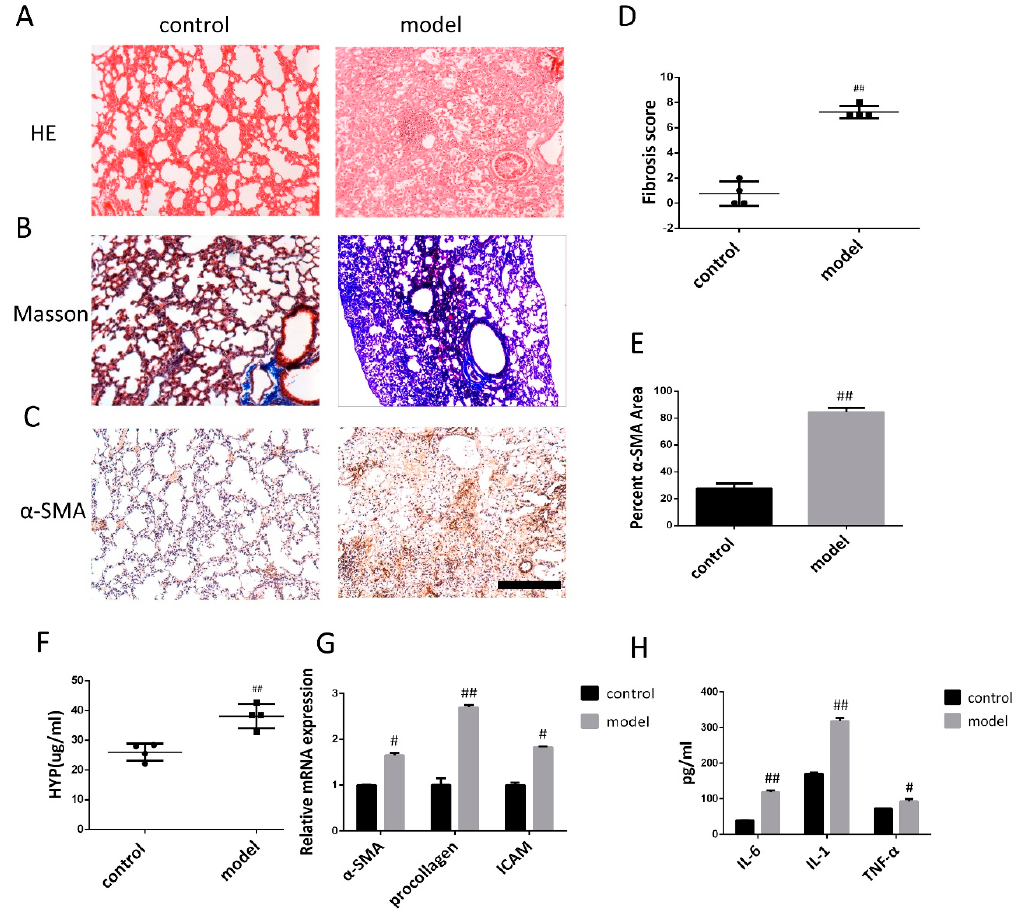
Figure 2. Pathological changes in lung tissue and the level of inflammatory cytokine in model of mice after bleomycin-induced pulmonary fibrosis formation. ( A ) The lung section from the mice that have undergone different treatments were stained by hematoxylin – eosin (HE) (n = 4 per group). ( B ) Lung sections from various treatment groups were subjected to Masson trichrome staining (n = 4 per group). ( C ) The expression of α -SMA was determined by using immunohistochemical analysis. Scale bar = 200 μ m for each picture (original magnification: ×100, n = 4 per group). ( D ) The lung fibrosis score based on the scoring from Ashcroft score. ( E ) Quantitative analysis of α -SMA positive area. ( F ) Hydroxyproline concentration in lung tissue was detected by using alkaline hydrolysis (n = 4 per group). ( G ) Change of α -SMA, procollagen, and ICAM transcripts were analyzed by qRT-PCR (n = 6 per group). ( H ) The expression of IL-6, IL-1, and TNF- α was examined by using ELISA in the lung and serum. All data are expressed as the mean ± SD. # p < 0.05, ## p < 0.01 versus control.